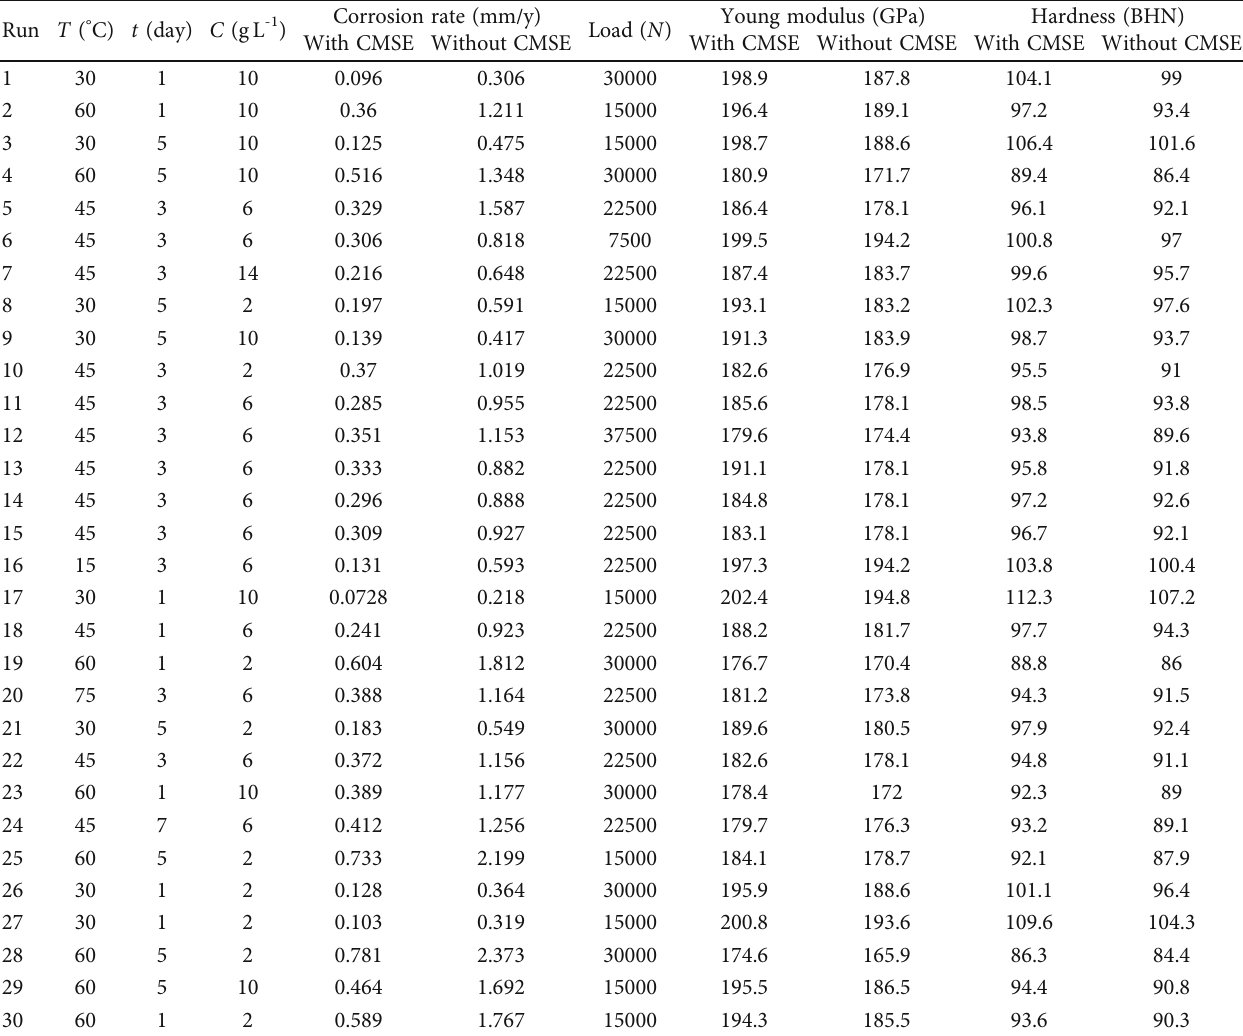
Figure 4: Adsorption isotherm plot of carbon steel in in 1M NaCl solution at 303 K in the absence and presence of various concentrations of Table 6: Batch experimental results showing CMSE in fl uence on corrosion rate, yield strength, Young modulus, and hardness of carbon steel in 1.0M NaCl at di ff erent temperature, time, and load.